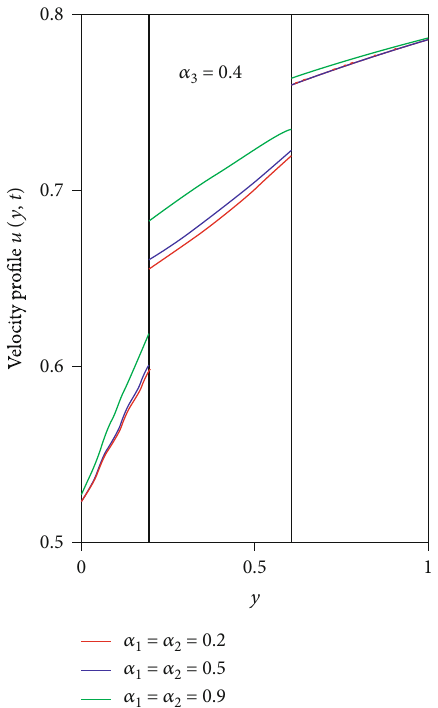
Figure 10: Velocity pro fi les u multilayer Maxwell fl uid at t = 0 : 19, λ and di ff erent values of fractional parameters α